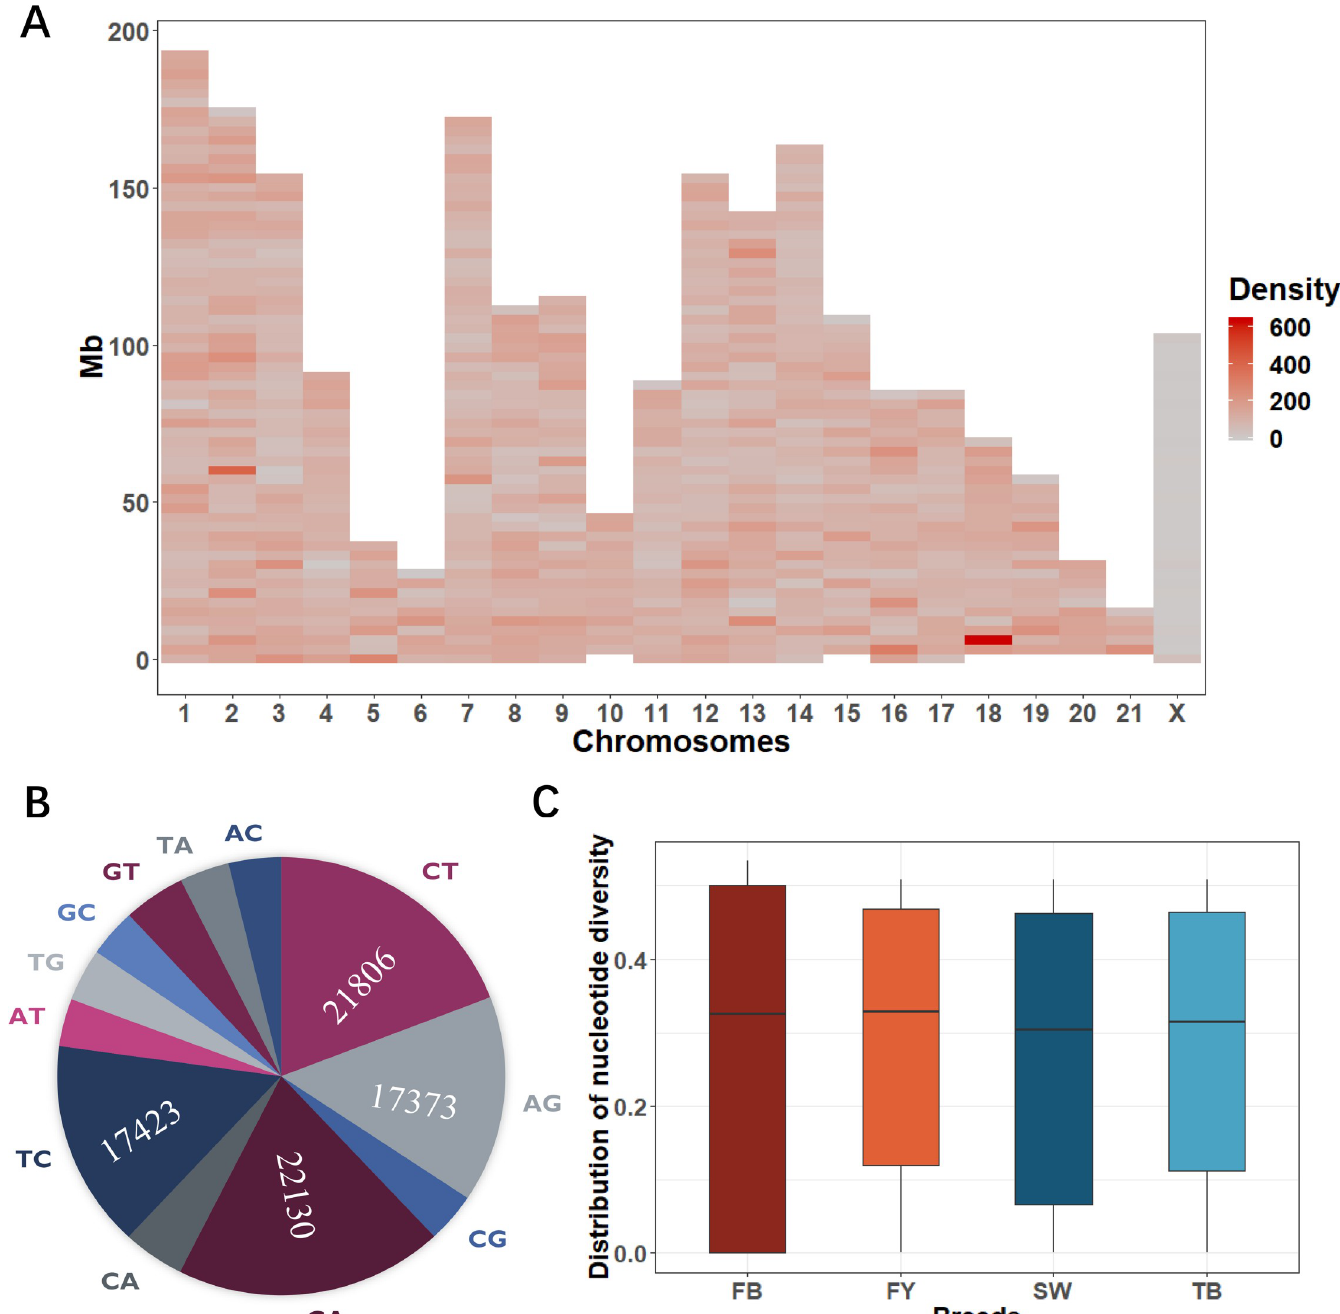
Fig 2. SNP distribution and nucleotide diversity. (A) Distribution density of SNPs across 22 chromosomes, in which each block represents a split bin. (B) Substitution types of SNPs in all populations. (C) Distribution density of the nucleotide diversity in four rabbit breeds.